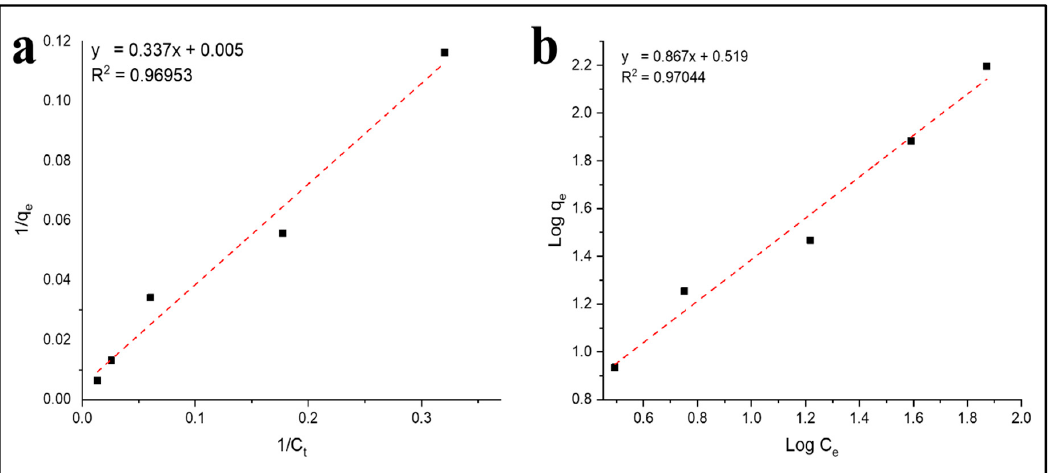
Figure 10. ( a ) Langmuir and ( b ) Freundlich isotherm model for Pb 2+ adsorption on the CA–PU film adsorbent. Table 4. The obtained values of the isotherm model parameters and coefficient of determination.